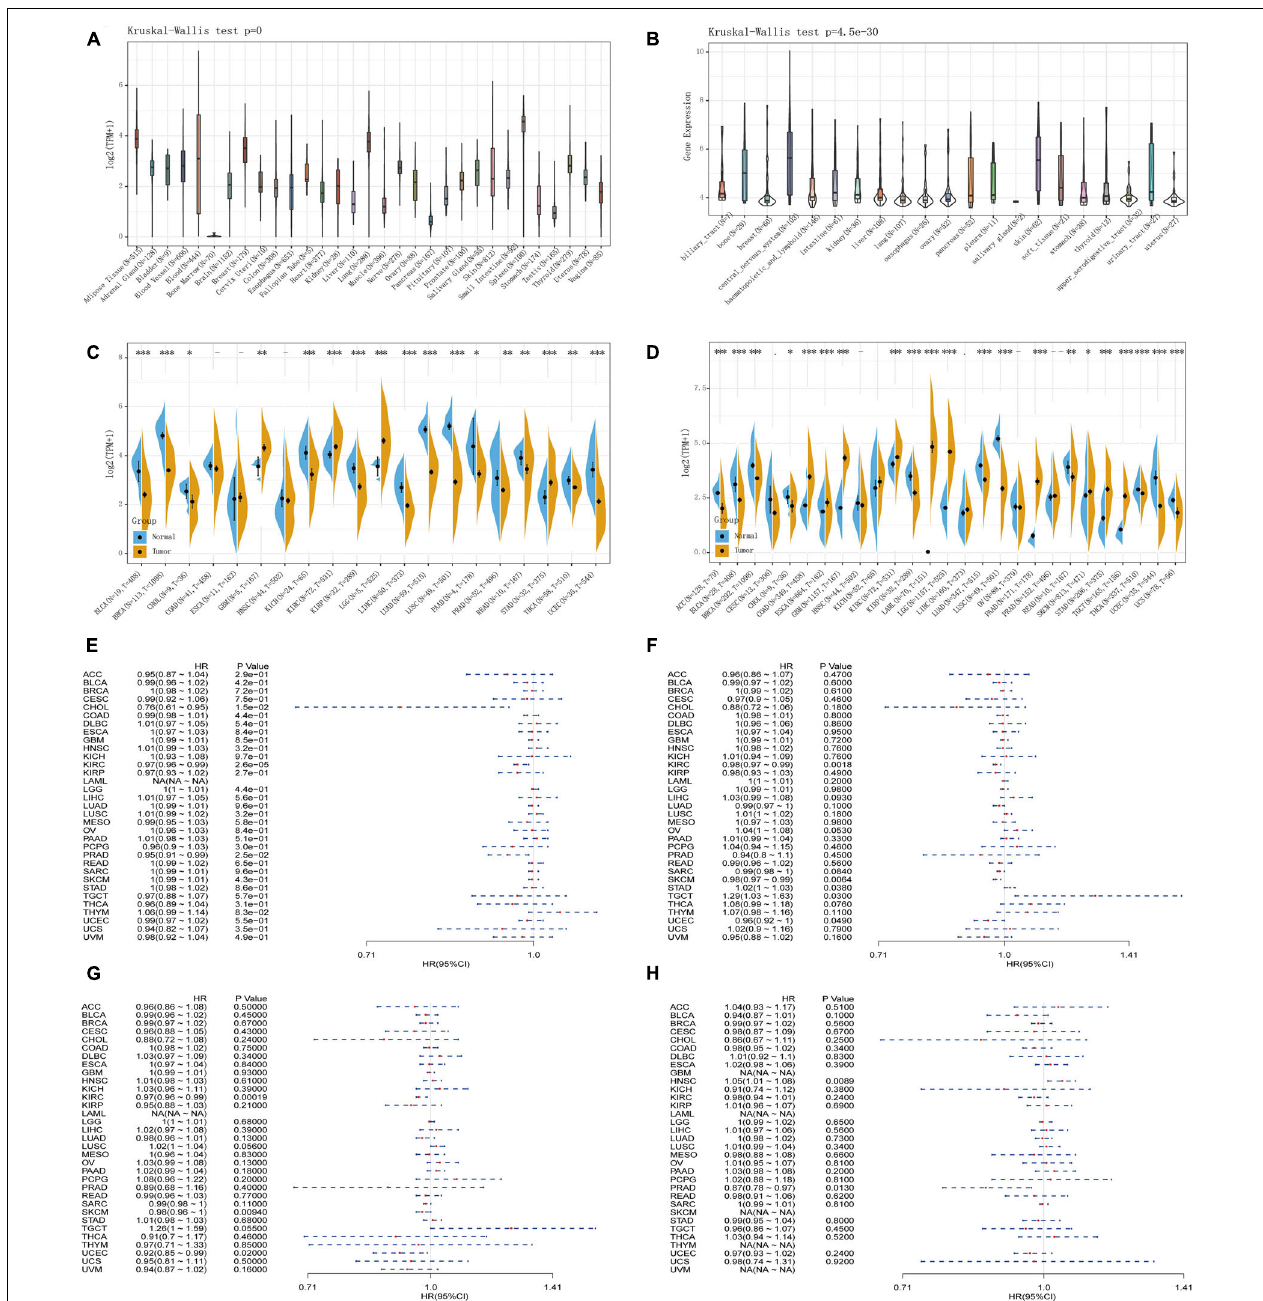
FIGURE 1 | Comprehensive analysis of the expression of Toll-like receptor 4 ( TLR4 ) gene in various databases. The Genotype-Tissue Expression (GTEx) data set showed that the TLR4 gene was basically not expressed in bone marrow or 31 other tissues and was most highly expressed in the spleen (A) . The CCLE database ( n = 1,019) showed that the TLR4 gene expression was lowest in salivary glands and highest in the central nervous system (B) . There are few normal tissue data in The Cancer Genome Atlas (TCGA) database (C) . The GTEx database ( n = 6,678) and the tumor data in TCGA database ( n = 9,498) are compared and displayed (D) . Compared with normal tissues, TLR4 gene expression is low in ACC, BLCA, BRCA, CESC, CHOL, HNSC, KIRP, LUAD, READ, HCA, UCEC, and UCS. In some data sets, COAD, ESCA, GBM, KICH, LGG, LIHC, PAAD, SKCM, STAD, and TGCT have high expressions. PFI showed that TLR4 was notably related to the prognosis of CHOL ( p = 0.015), KIRC ( p = 2.6e-5), and PRAD ( p = 0.025) (E) . OS displayed that TLR4 was markedly correlated with the prognosis of KIRC ( p = 0.0018), SKCM ( p = 0.0064), STAD ( p = 0.038), TGCT ( p = 0.03), and UCEC ( p = 0.049) (F) . DSS reflected that TLR4 was observably correlated with the prognosis of KIRC ( p = 0.00019), SKCM ( p = 0.0094), and UCEC ( p = 0.02) (G) . The prognosis of DFI showed that TLR4 was dramatically correlated with the prognosis of HNSC ( p = 0.0089) and PRAD ( p = 0.013) (H) . A p -value < 0.05 was considered statistically significant. The symbols “ ∗ ,” “ ∗∗ ,” and “ ∗∗∗ ” refer to p -values < 0.05, < 0.01, and < 0.001,